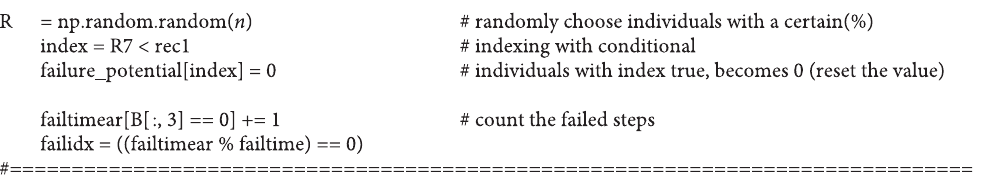
Figure 14: Code book: recovery delay.